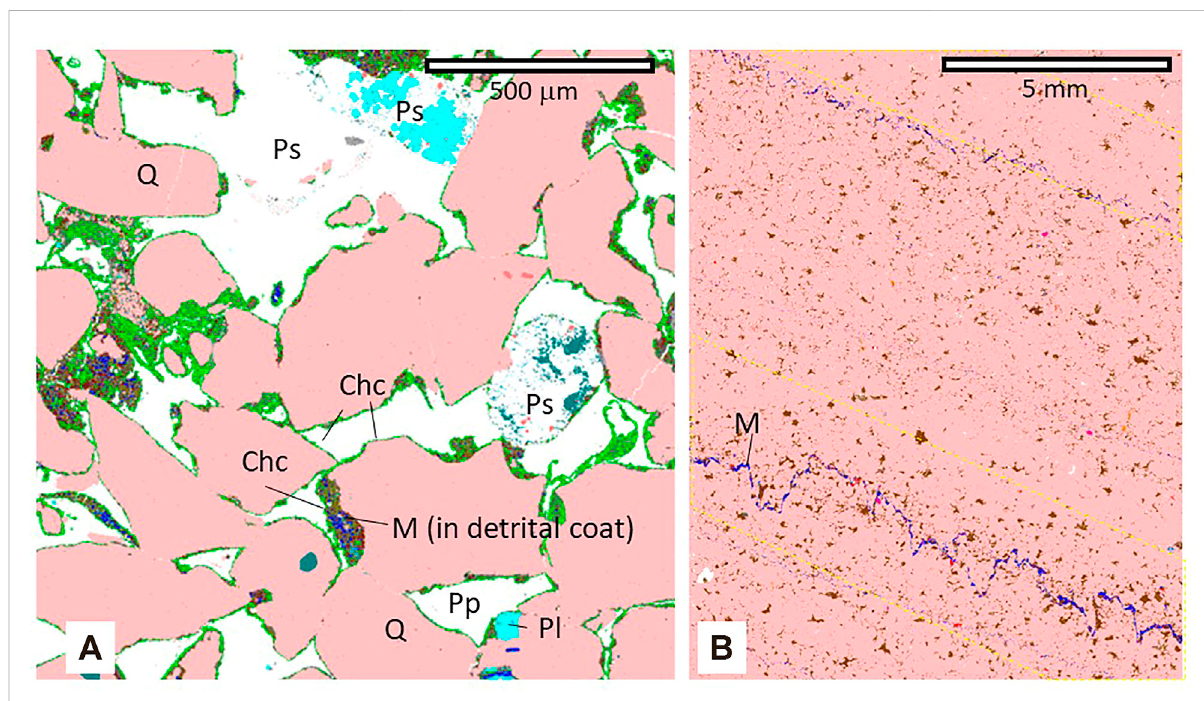
FIGURE 14 (A) Quartz (Q)-dominated Lower Jurassic deltaic sandstones from Halten Terrace, Norway, with minor K-feldspar (Kf) with extensive development of secondary porosity (Ps) due to the dissolution of feldspathic rock fragments. Much primary porosity (Pp) remains. Grains are coated withchlorite(Chc)althoughthedetritalclaycoat,preservedwithingrainembayments,containmuscovite(M)aswellaschlorite.Thedissolvedgrains have a patchy chlorite coat suggesting that dissolution occurred at least partly after the creation of chlorite grain coats (mineral colour index in Figure 3). (B) Permian low porosity aeolian sandstone from the Middle East with stylolites (within yellow dashed lines), locally enriched in muscovite (M) providing evidence of chemical compaction due to elevated effective stress. The stylolites are visible as they have concentrated clay minerals, and especially muscovite (M) at the sites of quartz dissolution. It is not possible to differentiate quartz cement and quartz overgrowths in